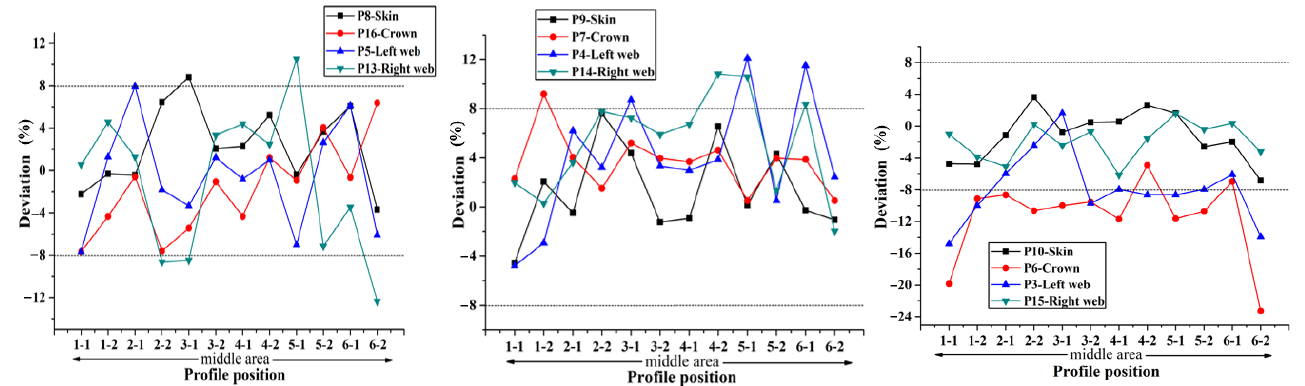
Figure 16. Comparison of dimensional stability of stringer manufactured by 90 HA bladder.